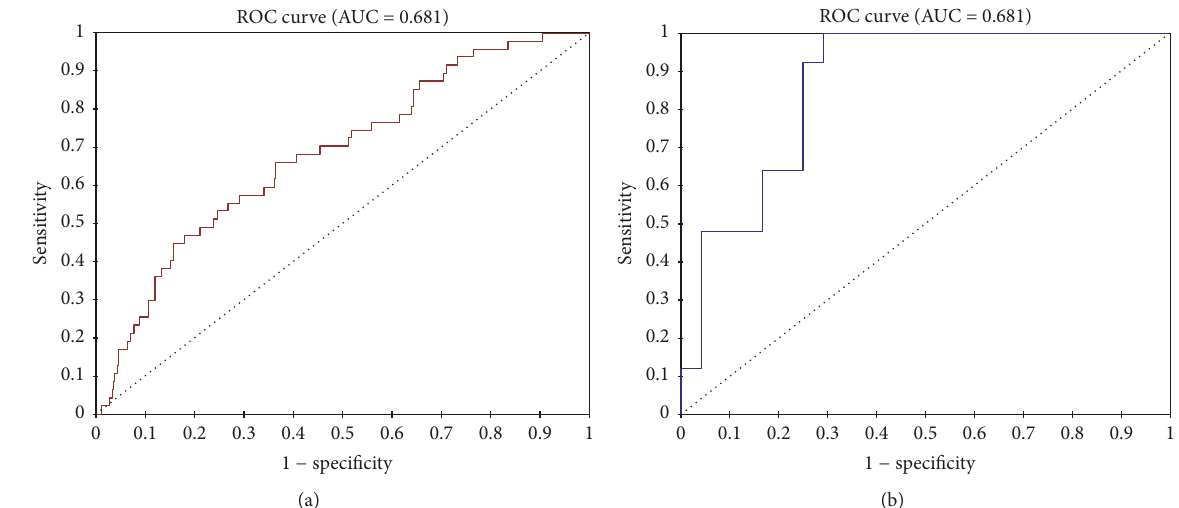
Figure 3: ROC curve of the relationship between Acute Renal Failure (ARF) and incidence of AF (a) and between ARF and mortality in patients with AF